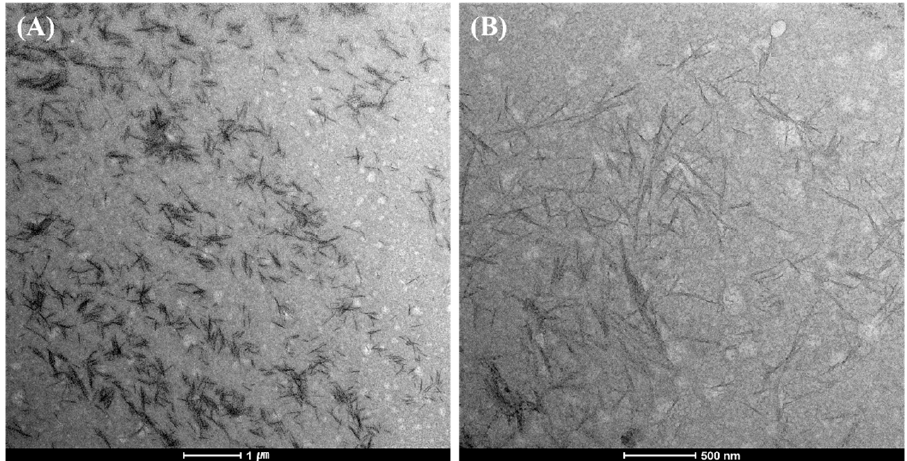
Figure 1. TEM images of CNC ( A ) 1500×, ( B ) 10,000×.